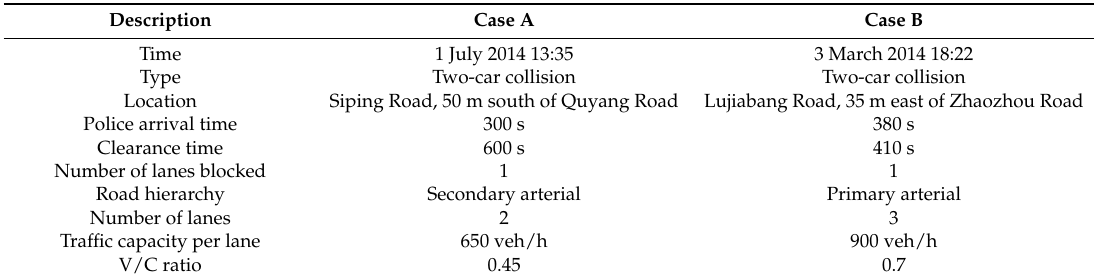
Table 4. Information for selected